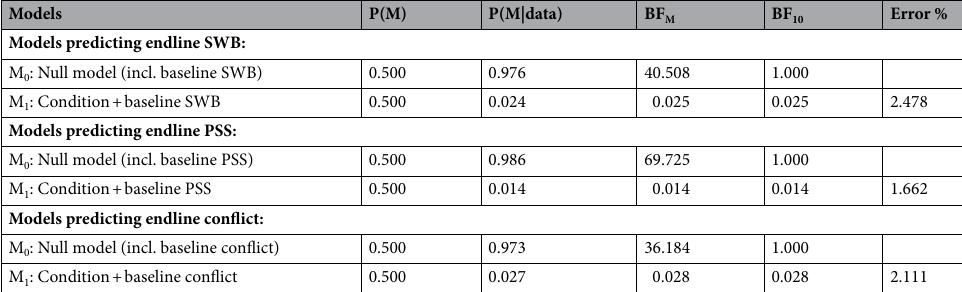
Table 1. Bayesian model comparisons. Reporting the prior model probability, P(M); the posterior model probability, P(M|data); the posterior model odds, BF M ; and the Bayes Factor indicating the predictive performance of a given model divided by the predictive performance of the null model (BF 10 ).